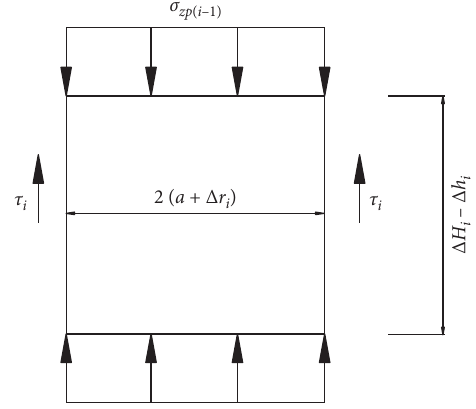
Figure 4: Stress analysis of the i- th microelement of